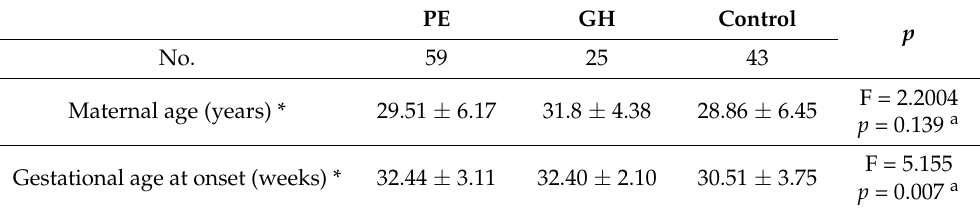
Table 1. Clinical findings in the studied groups.